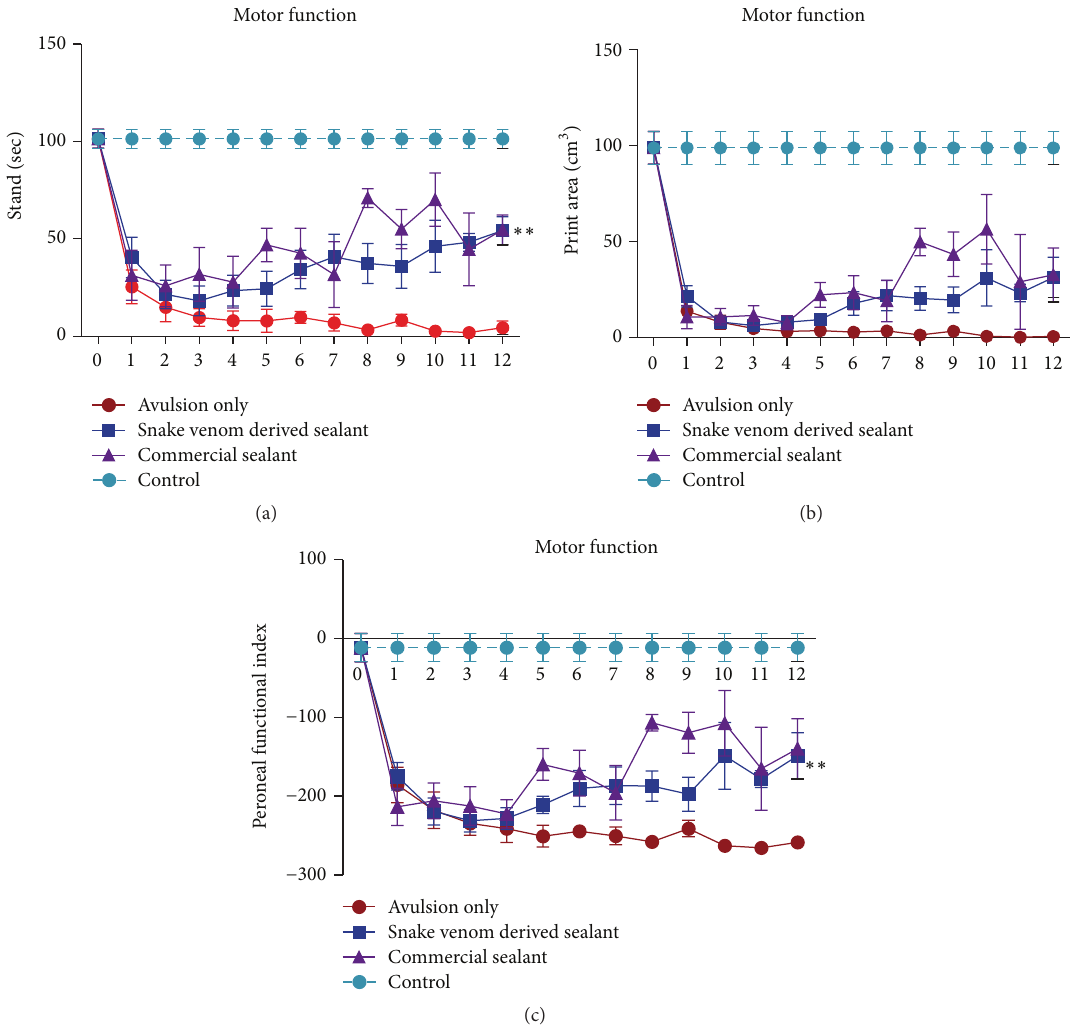
Figure 7: Motor function recovery up to 12 weeks after lesion (0 = preoperative). (a) Graph of the duration of contact of a paw with the glass plate in a step cycle (seconds). (b) Graph of the surface area of the complete print (cm 3 ). (c) Graph of the peroneal nerve functional index. Observe the significantly improvement of motor performance in the fibrin sealant reimplanted groups compared to VRA Only from the first week after lesion until the twelfth week. A significant restoration of weight-bearing capacity following avulsion and reimplantation with the fibrin sealants is also observed. Values are expressed as the ratio IL/CL (ipsi/contralateral sides) pressure exerted by the paw on the CatWalk platform. ∗∗ 𝑝 < 0.01